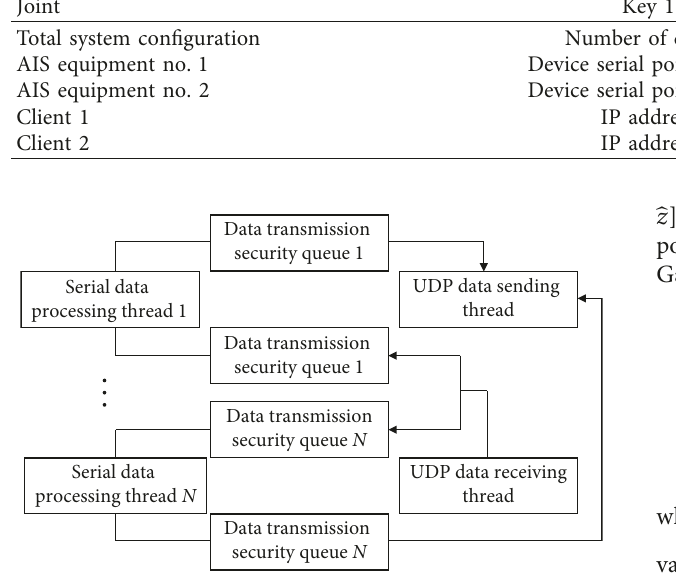
Figure 4: Multithread data transfer process.